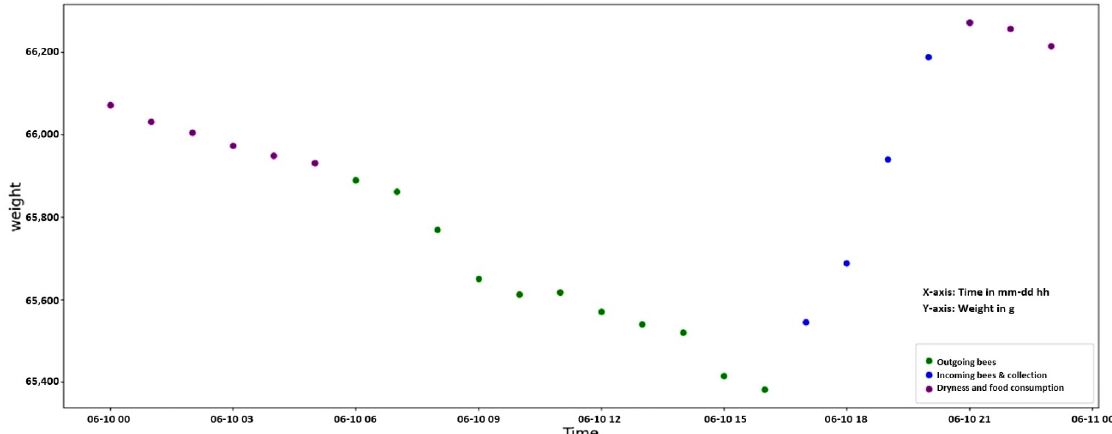
Figure 7. Hourly analysis showing moisture changes in the beehive, adult bees forming and honey production and number of bees declining summer season.